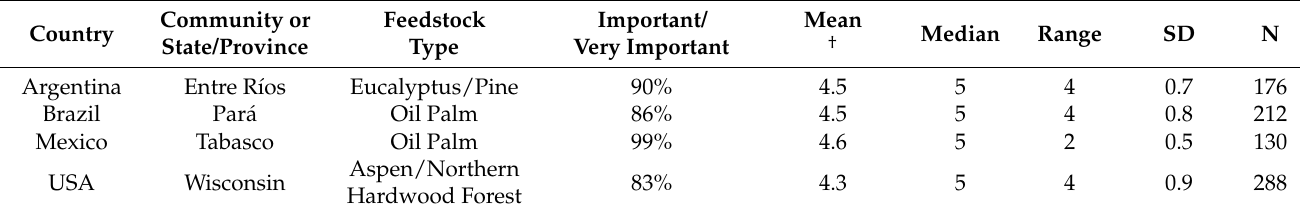
Table 1. How important are birds to you and your household (Argentina, Brazil, Mexico) OR is it important to you that forests provide bird habitat (USA)? † Likert Scale: 1 = Not at all important, 5 = Very important.